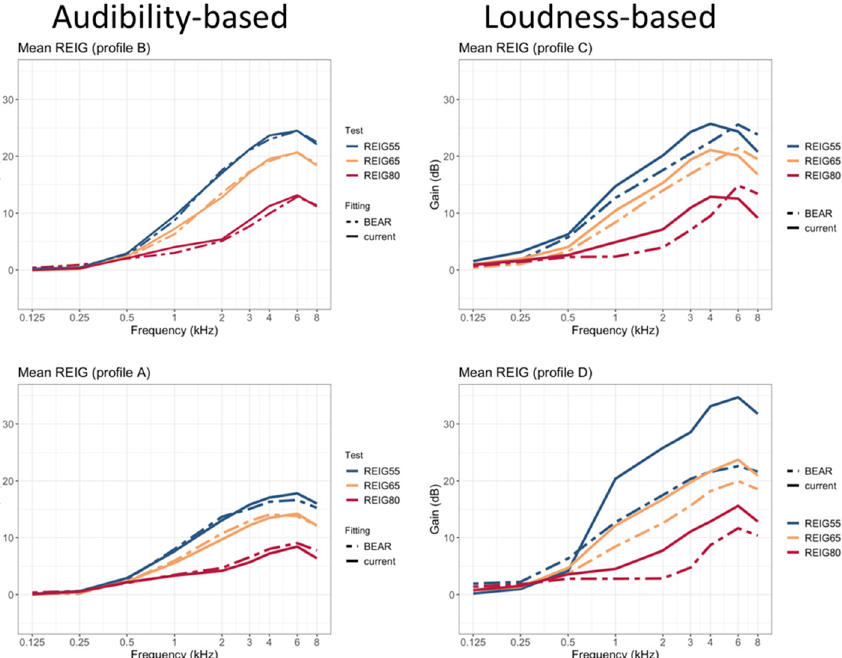
Figure 4. Mean real-ear insertion gains measured as part of the clinical study. Each panel shows data for one profile. Measurements made on participants fitted with the “current” strategy are shown with solid lines, while those made with the “BEAR” strategy are shown with dashed lines. The blue, yellow, and red lines represent input levels of 55, 65, and 80 dB SPL, respectively.